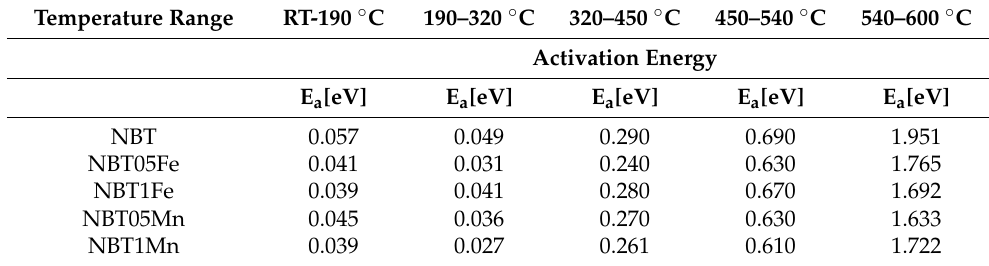
Figure 6. Evolution of DC electric conductivity with 1000/T of the investigated samples. Simultaneously, the activation energies deduced from Arrhenius plots decreased (Table 3). Table 3. Activation energy of investigated materials estimated from DC electric conductivity mea-